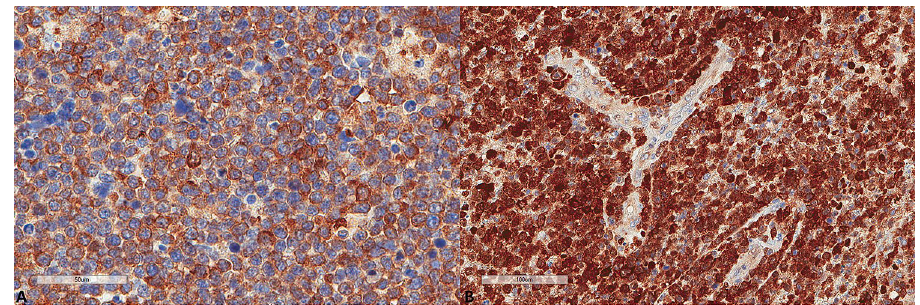
Figure 5. Representative images of p62 expression. ( A ) Lower p62 expression (× 400). ( B ) Higher p62 expression (× 400).